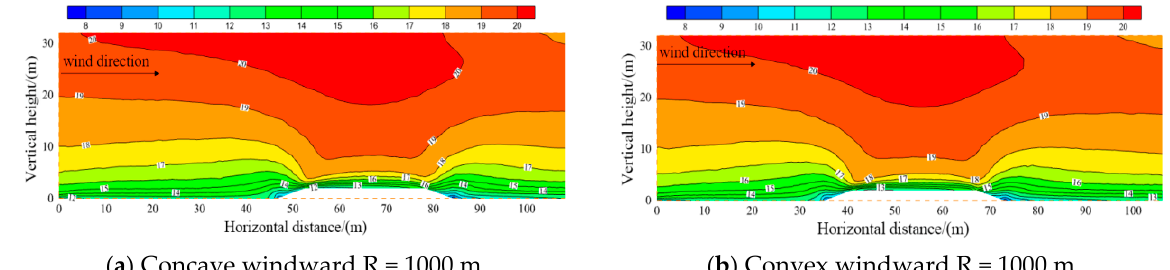
Figure 8. Flow-field distribution at the cross-section of embankment Y = 150 m under different surface windward forms.